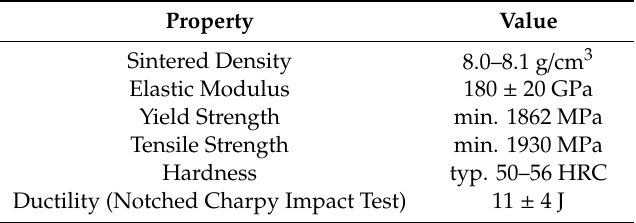
Table 1. Mechanical properties of the specimens.